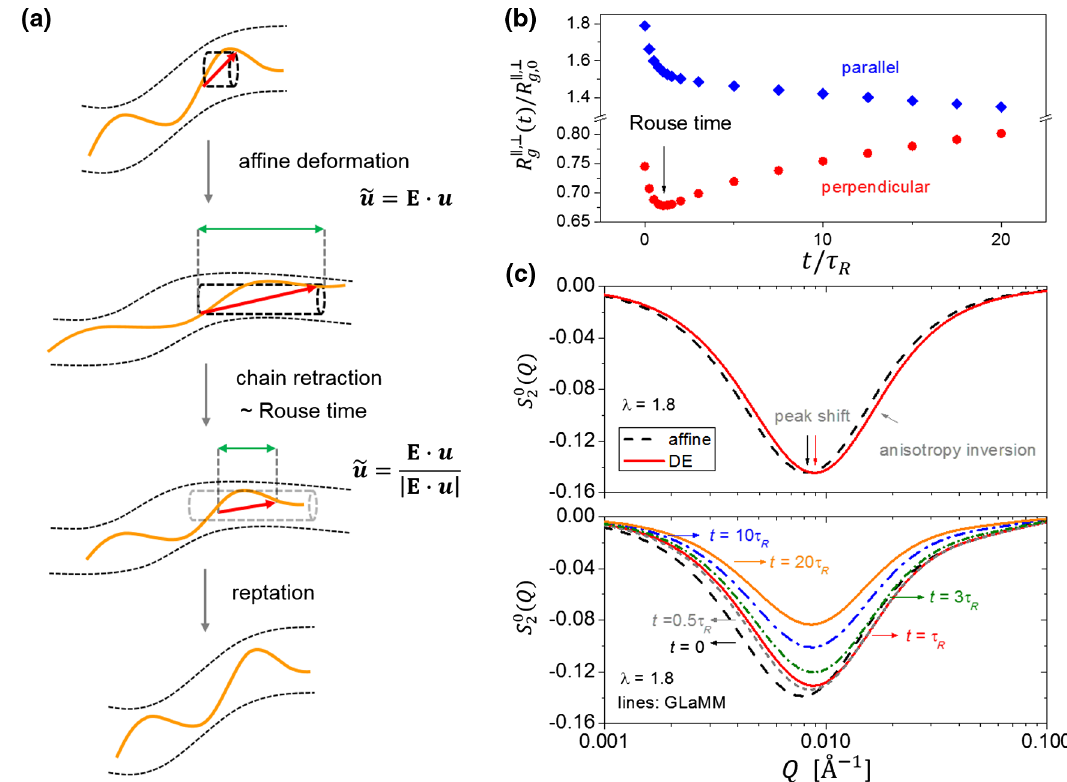
FIG. 3. (a) Illustration of the molecular relaxation mechanism envisioned by the Doi-Edwards theory. The chain conformation immediately after the step-strain deformation can be described by the affine transformation. The chain retraction around Rouse time quickly equilibrates the contour length and leads to a reduction of all components of the radius of gyration tensor. The molecular relaxation continues via reptation after chain retraction. (b) Evolution of the radius of gyration in the parallel and perpendicular directions to stretching, as predicted by the GLaMM model for an entangle polystyrene ( Z ¼ 34 ) after a step deformation of λ ¼ 1 . 8 , performed with a constant crosshead velocity v ¼ 40 l 0 = τ . (c) Upper panel: Expansion coefficient S 0 2 ð Q Þ before and after the chain R retraction, calculated using the affine model and Doi-Edwards (DE) model, respectively. Lower panel: Predictions from the GLaMM model. Our choice of the GLaMM parameters follows the standard practice in the literature